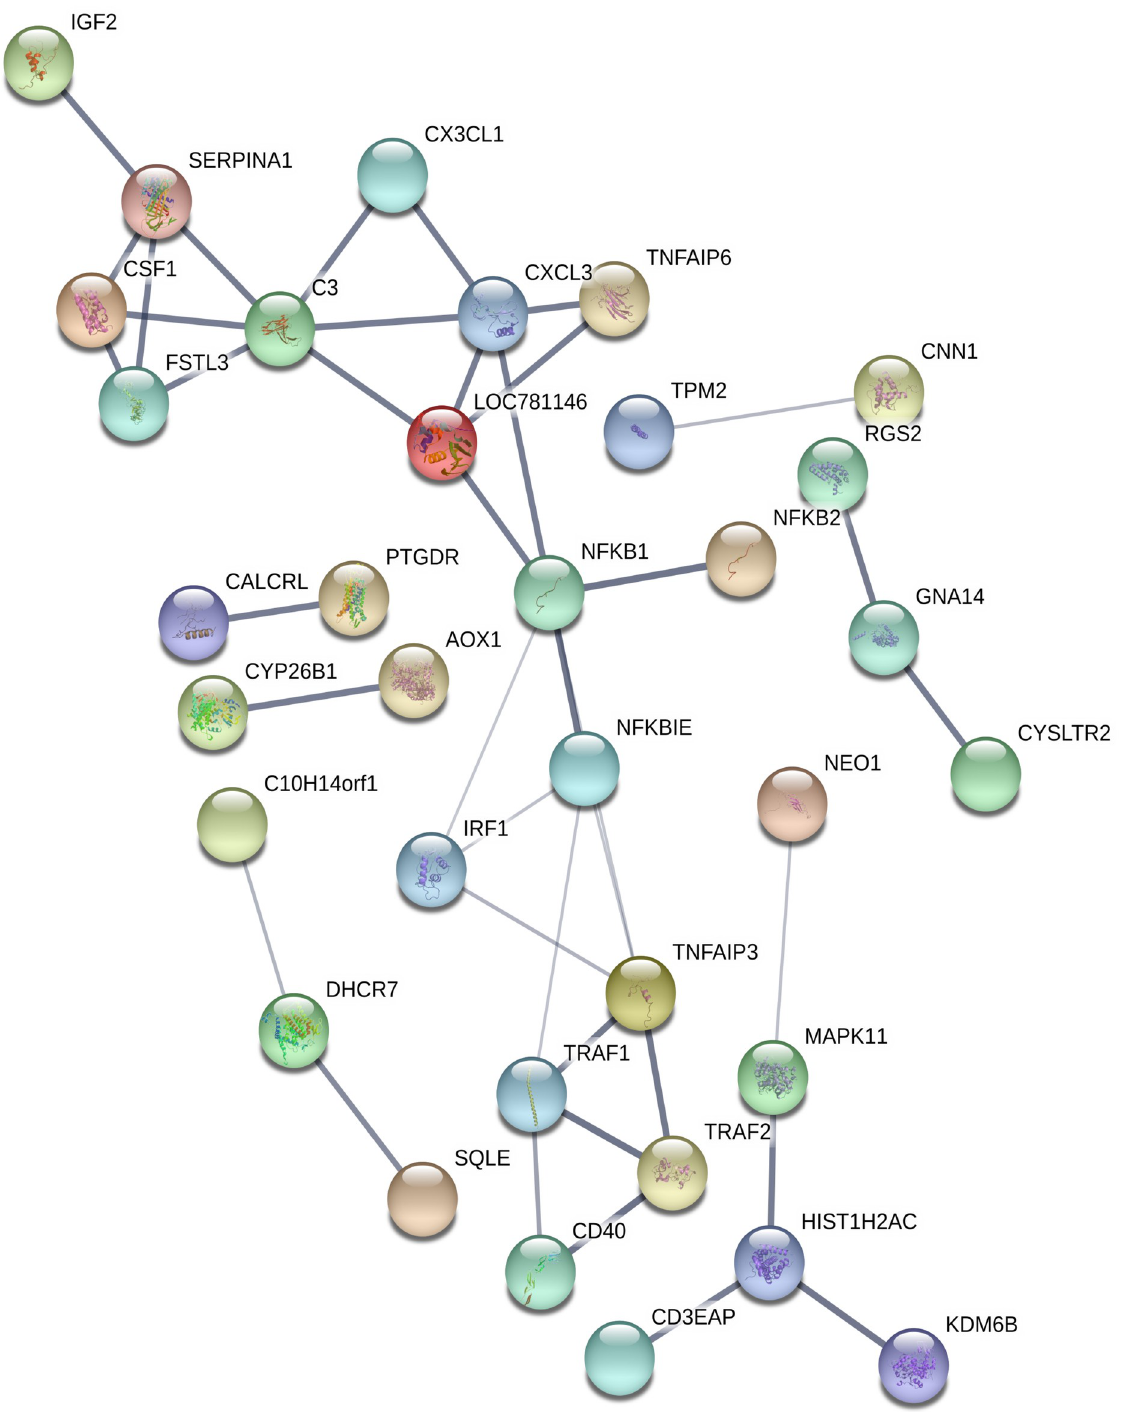
Fig 4. Predicted protein interaction networks from the DEGs following sPIF treatment. Interactions are based on the prediction methods of: neighbourhood, gene fusion, co-occurrence, co-expression and experiment databases in STRING version 11.0. Only connected nodes within the DEGs dataset are displayed. Edges between nodes represent predicted protein-to-protein interactions coded by DEGs. Thicker lines demonstrate a greater strength of data support from the prediction methods.